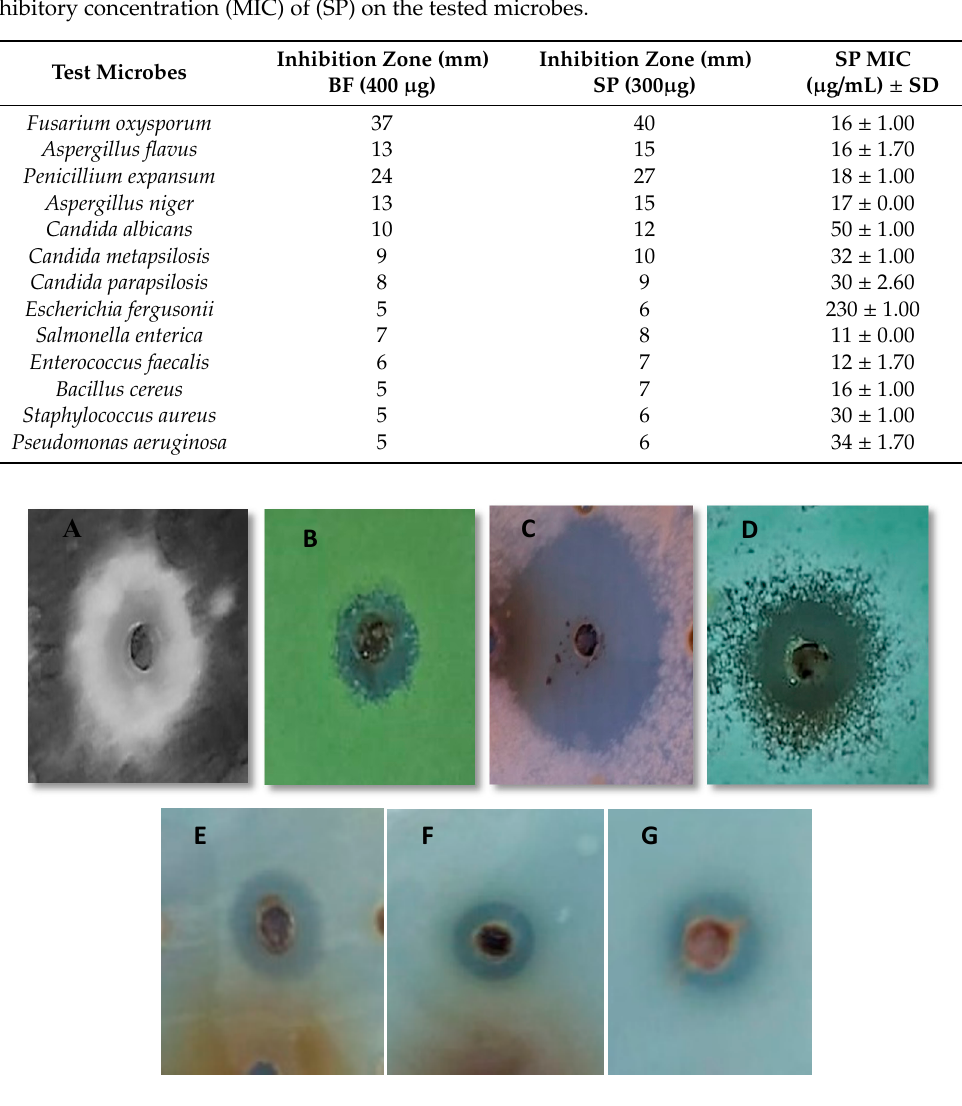
Figure 3. Inhibition Zone of active fraction against ( A ) Aspergillus niger , ( B ) Aspergillus flavus , ( C ) Fusarium oxysporum , ( D ) Penicillium expansum , ( E ) Candida albicans , ( F ) Escherichia fergusonii and ( G ) Enterococcus faecalis .